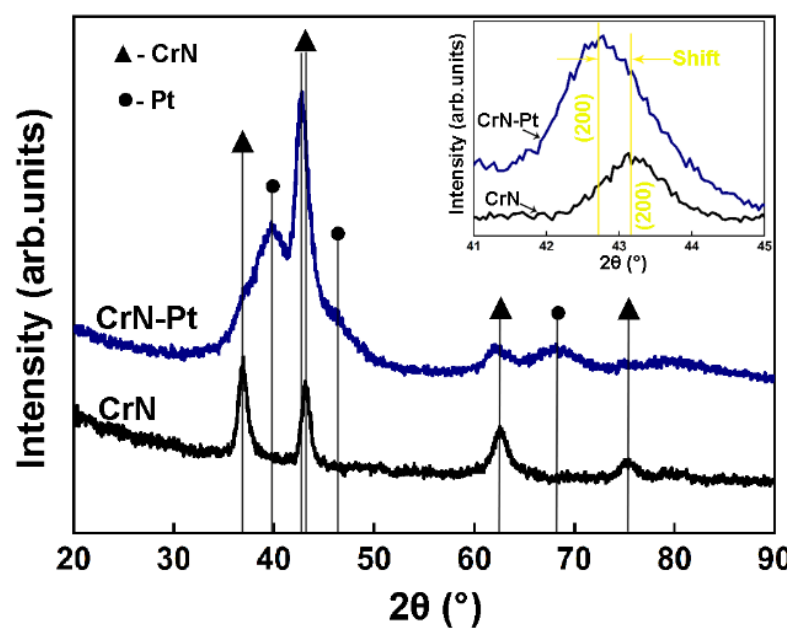
Figure 2. XRD patterns of the as-deposited CrN and CrN – Pt coatings.